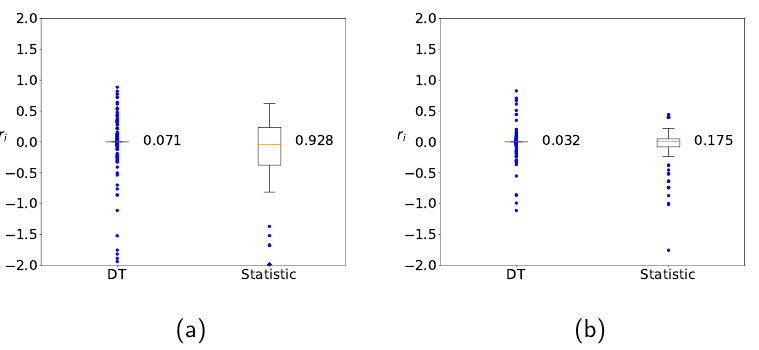
Figure 9. Distribution of predicted values for Zener diodes with the DT method ( a ) without clustering and ( b ) with clustering.